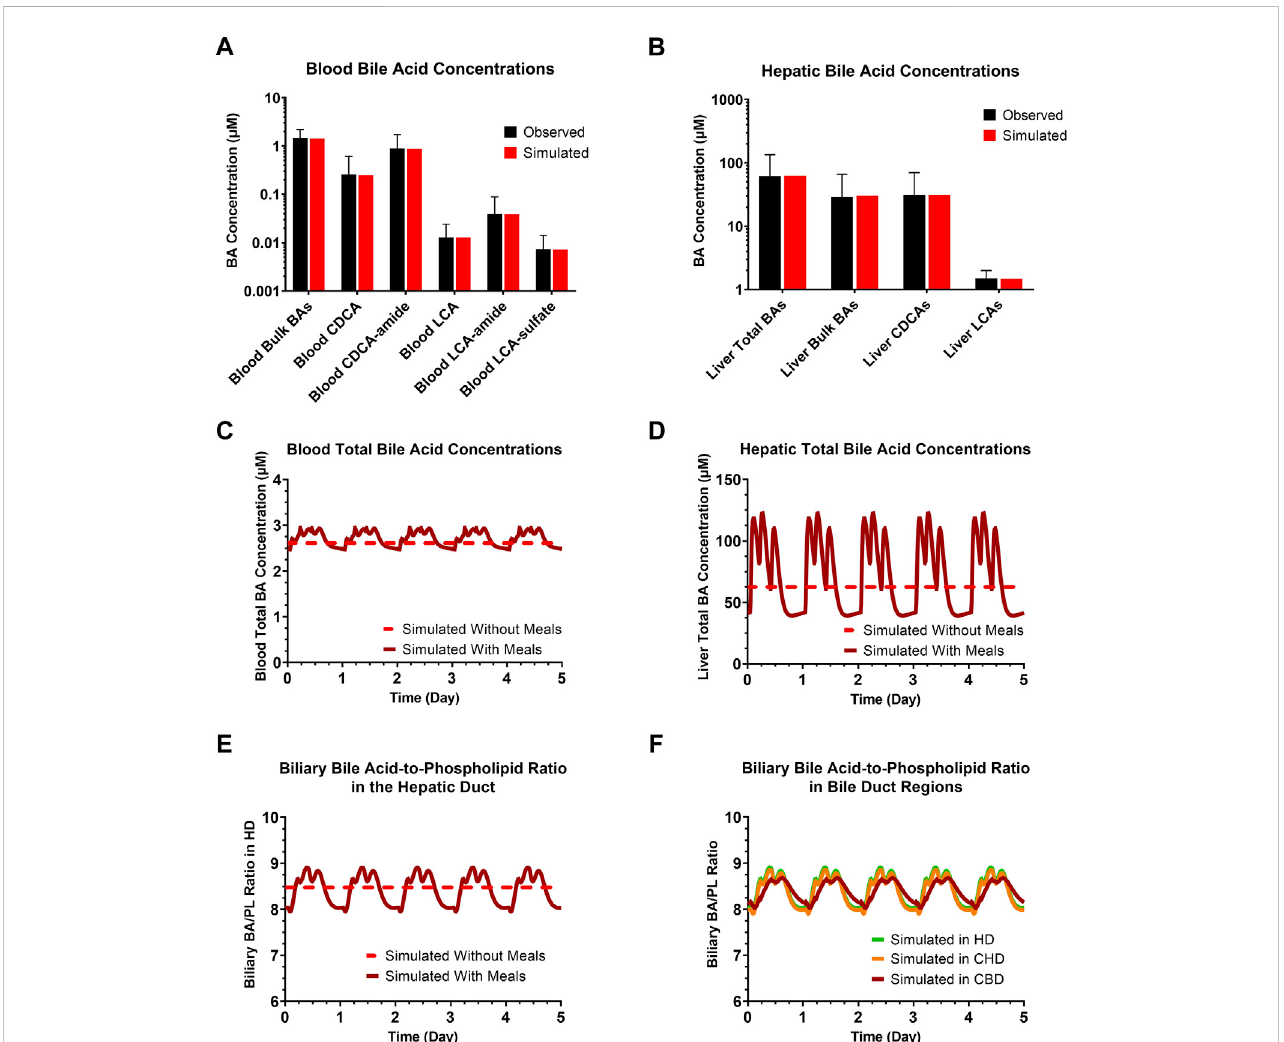
FIGURE 2 Clinically observed and simulated (A) blood BA concentrations and (B) liver BA concentrations. Observed data are presented as mean ± SD. Simulations with or without meals of blood total BA concentrations (C) , hepatic total BA concentrations (D) , the biliary BA/PL ratio in the HD (E) , and biliary BA/PL ratio in the HD, CHD and CBD (F) . BA, bile acid; CBD, common bile duct; CDCA, chenodeoxycholic acid; CHD, common hepatic duct; HD, hepatic duct; LCA, lithocholic acid; PL,